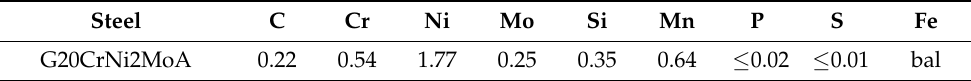
Table 1. Chemical compositions of G20CrNi2MoA bearing steel (wt.%).